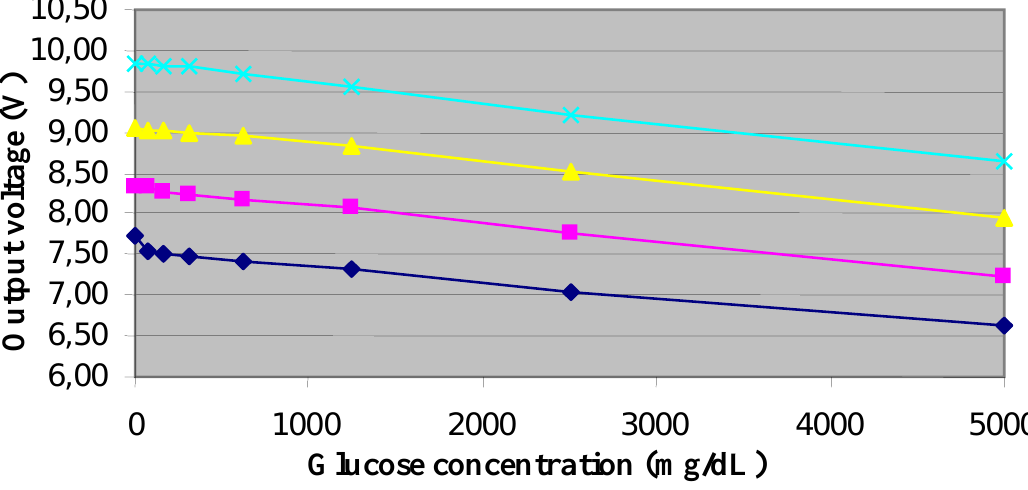
Figure 3. Output voltage of the electromagnetic sensor in relation to the glucose concentration of samples in the 0.9% sodium chloride set (rhombus), 1.0% set (square), 1.1% set (triangle), 1.2% set (x symbol), at room temperature and the pump powered at 10